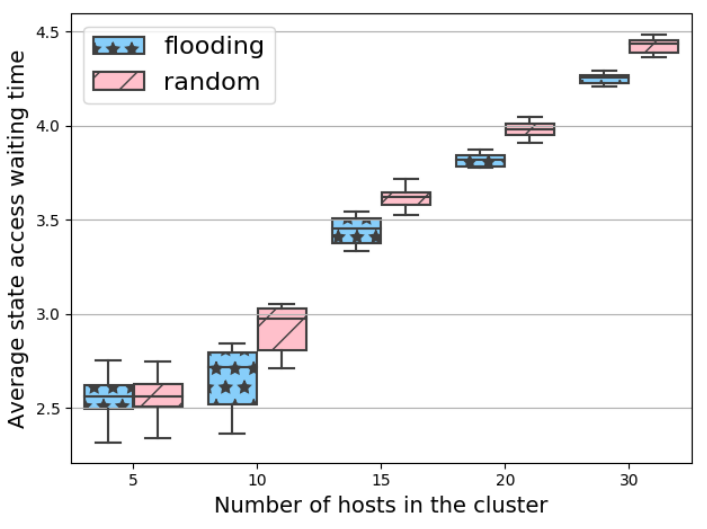
Figure 6. Performance of the flooding and the simple algorithm depending on the number of hosts in the